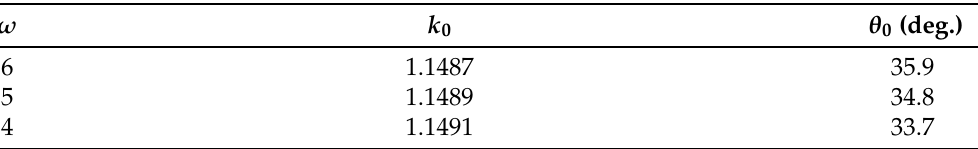
Table A2. Convergence of the position ( k 0 , θ 0 ) of the zero in f Ps with respect to variations in ω for the p -wave only. For the s -, d - and f -wave, the ω value is 8, 5 and 4, respectively.